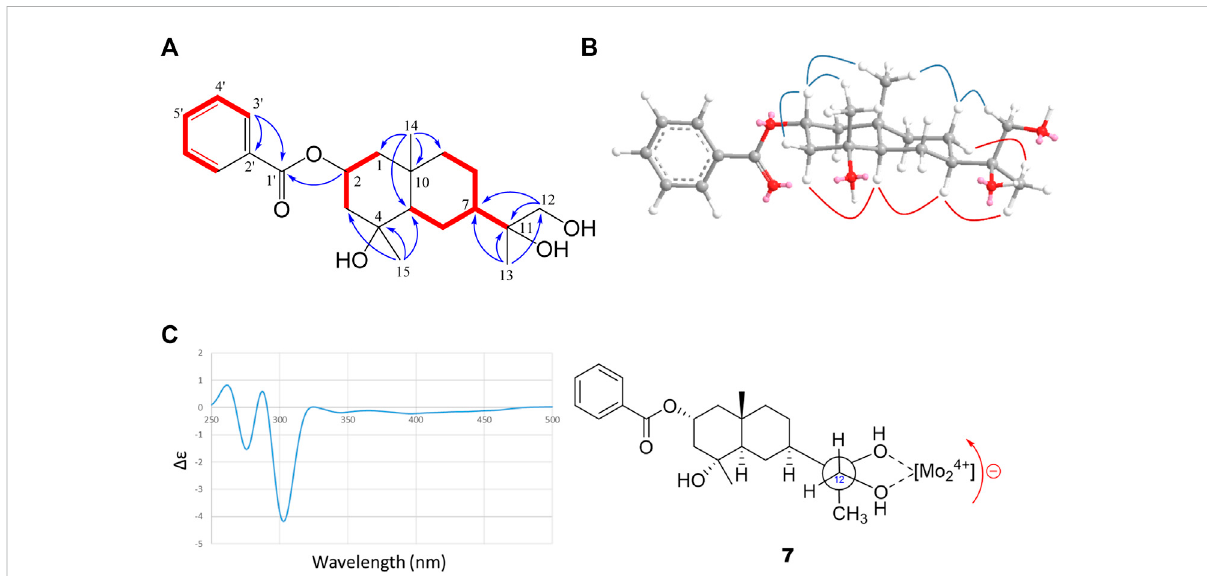
FIGURE 4 2D correlations and CD spectrum of 7 . (A) Key HMBC and 1 H – 1 H COSY correlations. (B) Main NOESY correlations. (C) CD spectrum of 7 with Mo 2 (OAc) 4 in DMSO with the inherent CDs subtracted.